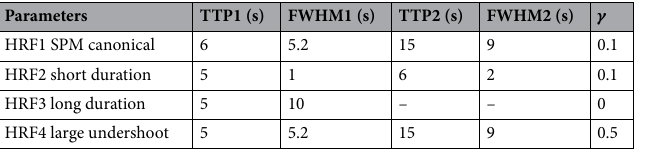
Table 1. Parameters for the HbO simulated HRFs . TTP time to peak, FWHM full width at half maximum.